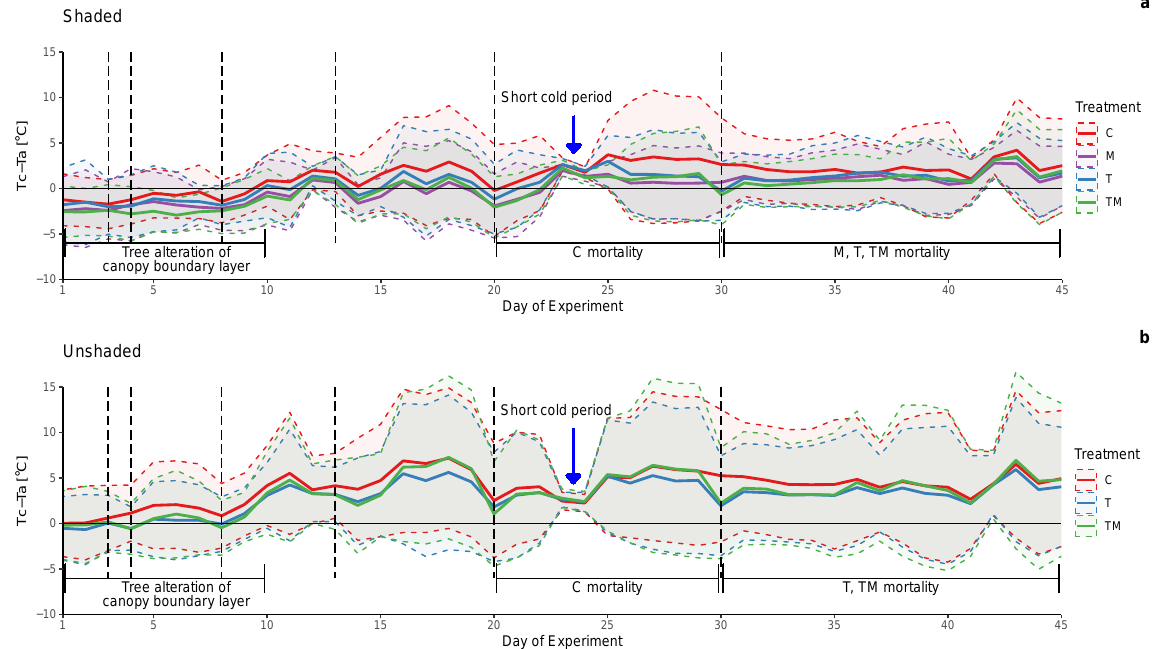
Figure 4. Daily means of the daytime (8 a.m.–8 p.m.) difference between seedling canopy temperature and ambient air temperature (canopy minus ambient) across treatment groups for shaded (Panel ( a )) and unshaded (Panel ( b )) microsites. Negative values indicate days where seedling canopy temperature was lower than ambient air temperature, and variation in these values is presumed to be the consequence of variation in latent energy exchange via transpiration within tree canopies. Dashed lines indicate watering days. Shading illustrates ± 1 standard deviation about daily mean values. Contraction of standard deviations occurred on two days during a short cold event (indicated by an arrow). Values for treatments of higher magnitude (treatment M) in unshaded microsites are not shown due to sensor